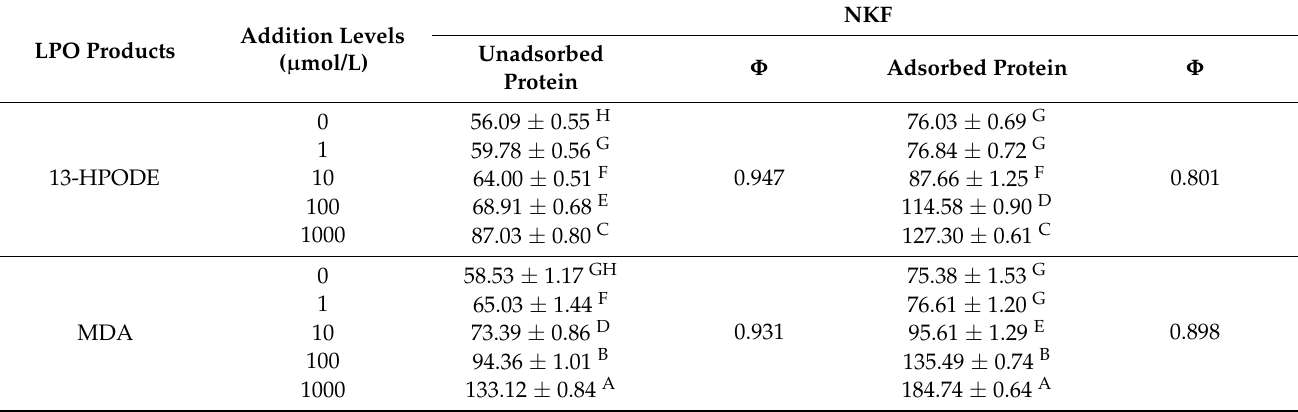
Table 6. NKF of unadsorbed and adsorbed proteins extracted from the O/W emulsion oxidized by different levels of 13-HPODE or MDA for 48